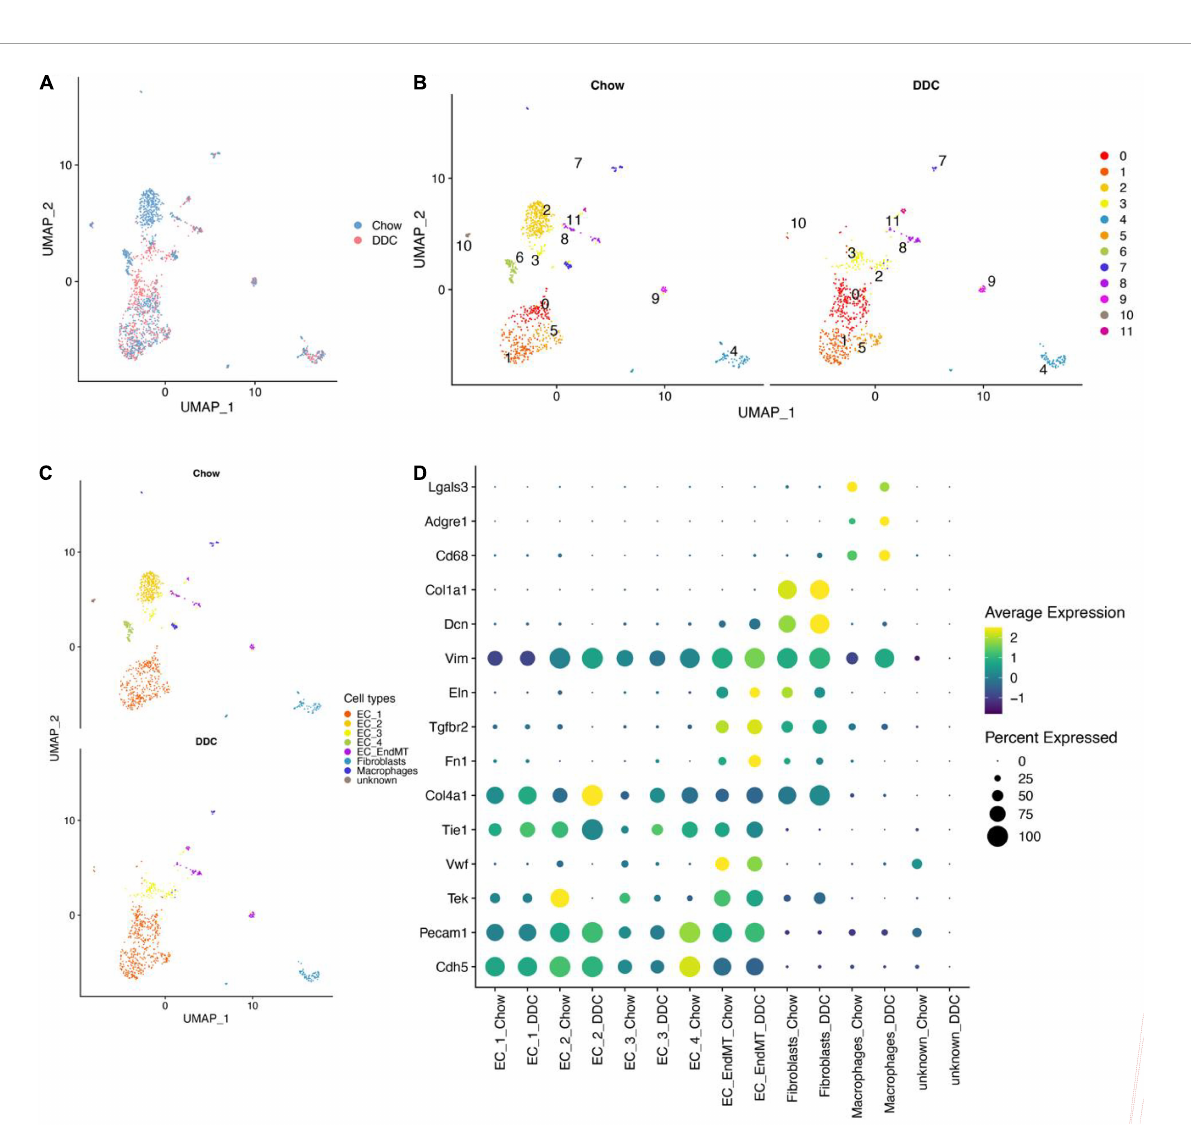
FIGURE1 EC-enriched single-cell RNA-seq analysis of mouse heart and aorta. (A) UMAP plot showed cell aggregation in the Chow group and DDC group. The colors represent different groups. (B) UMAP plot showed the clusters of cells from the Chow and DDC groups after cell clustering. Different colors indicated different cell clusters; the Chow group showed 12 clusters of cells, while the DDC group showed 11 clusters. (C) UMAP plot showed 7 cell types identified in the Chow and DDC groups, among others, containing 5 endothelial cell subtypes (EC_1, EC_2, EC_3, EC_4, EC_EndMT). (D) Dot plots showed the expressions of selected marker genes for each cell type between the groups. Dot sizes indicated the percentage of cells expressing each gene while dot color represented the average expression level in each group. The vertical axis showed the endothelial cell marker genes (Cdh5, Pecam1, Tek, Vwf, Tie1, and Col4a1), mesenchymal marker genes (Fn1, Tgfbr2, and Eln), fibroblast marker genes (Dcn and Col1a1) and macrophage marker genes (Cd68, Adgre1, and